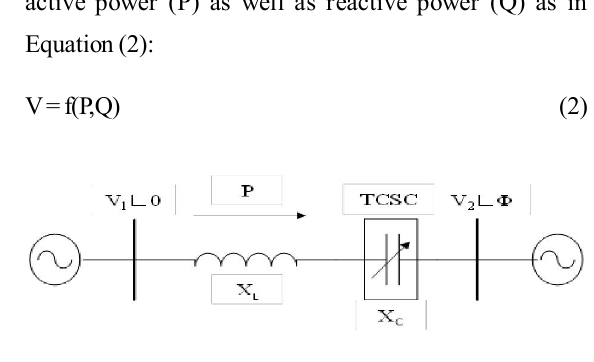
FIG. 1. SERIES COMPENSATED TRANSMISSION LINES